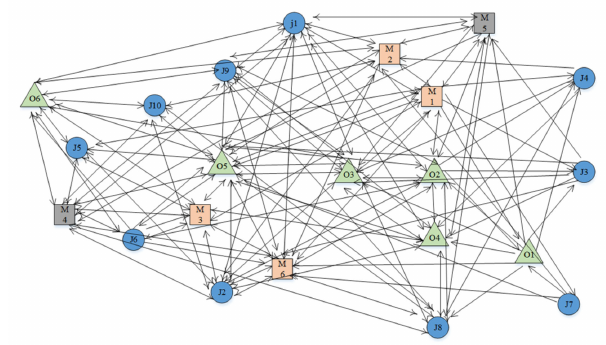
Figure 10. Collaborative network for the dataset 10 by 6